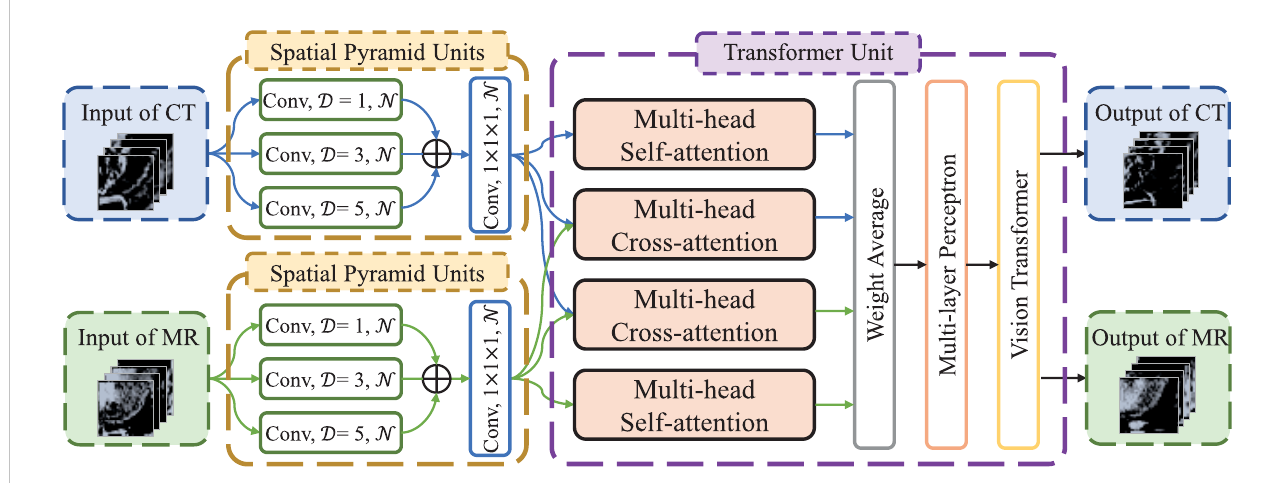
FIGURE 2 The architecture of modality fusion module. D is dilation rate in the convolutional layers and N is the number of convolutional kernels, which is set to 4, 8 and 16, respectively, in the three modality fusion